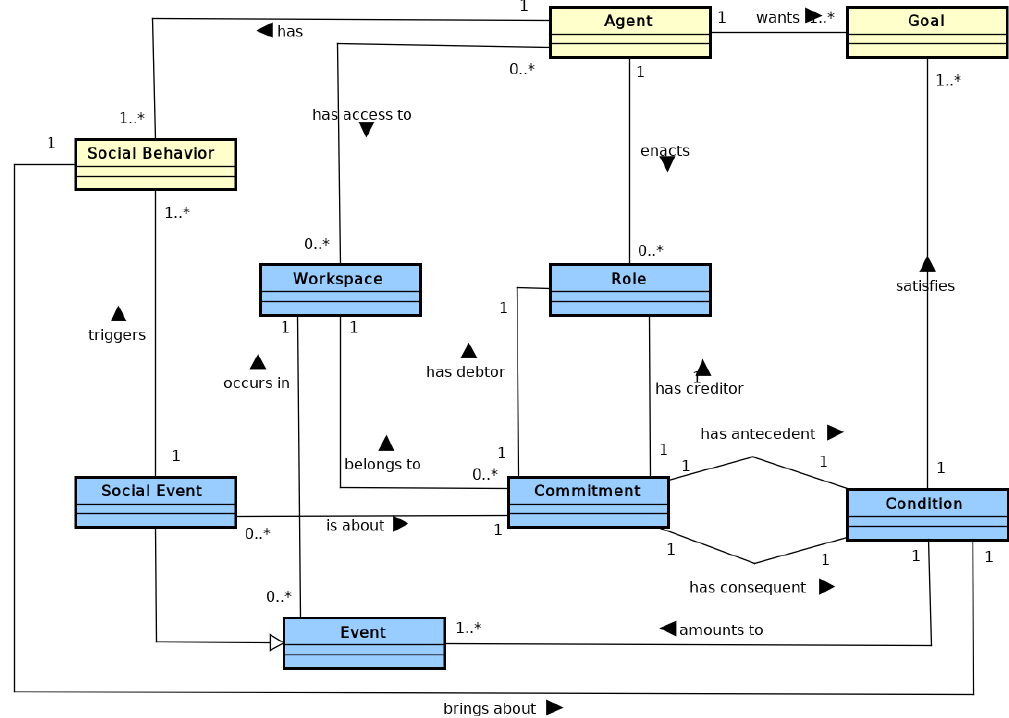
Figure 3. The conceptual architecture of agents and their relationships.